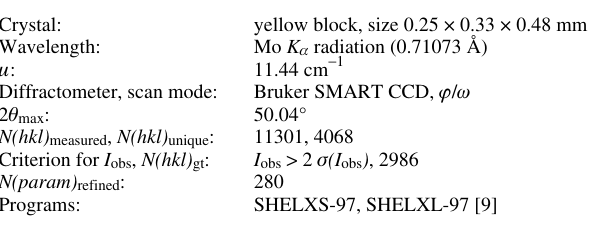
Table 1. Data collection and